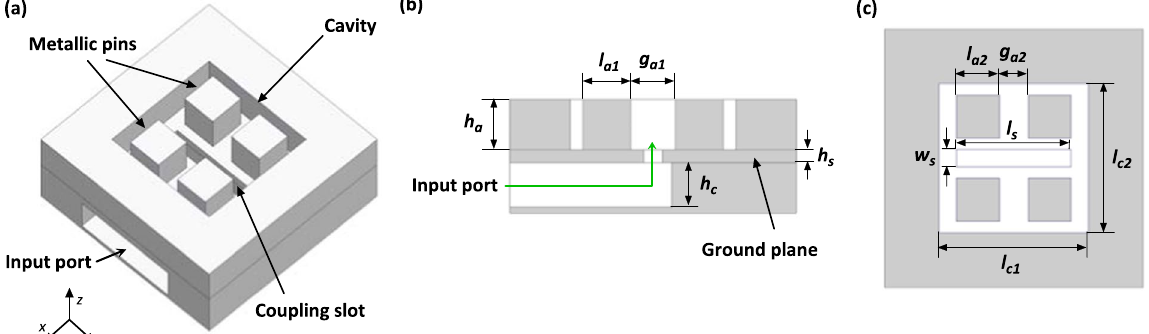
Figure 1. Geometry of the wideband cavity-backed slot antenna with corrugated surface. ( a ) Perspective view, ( b ) side view, and ( c ) top view.